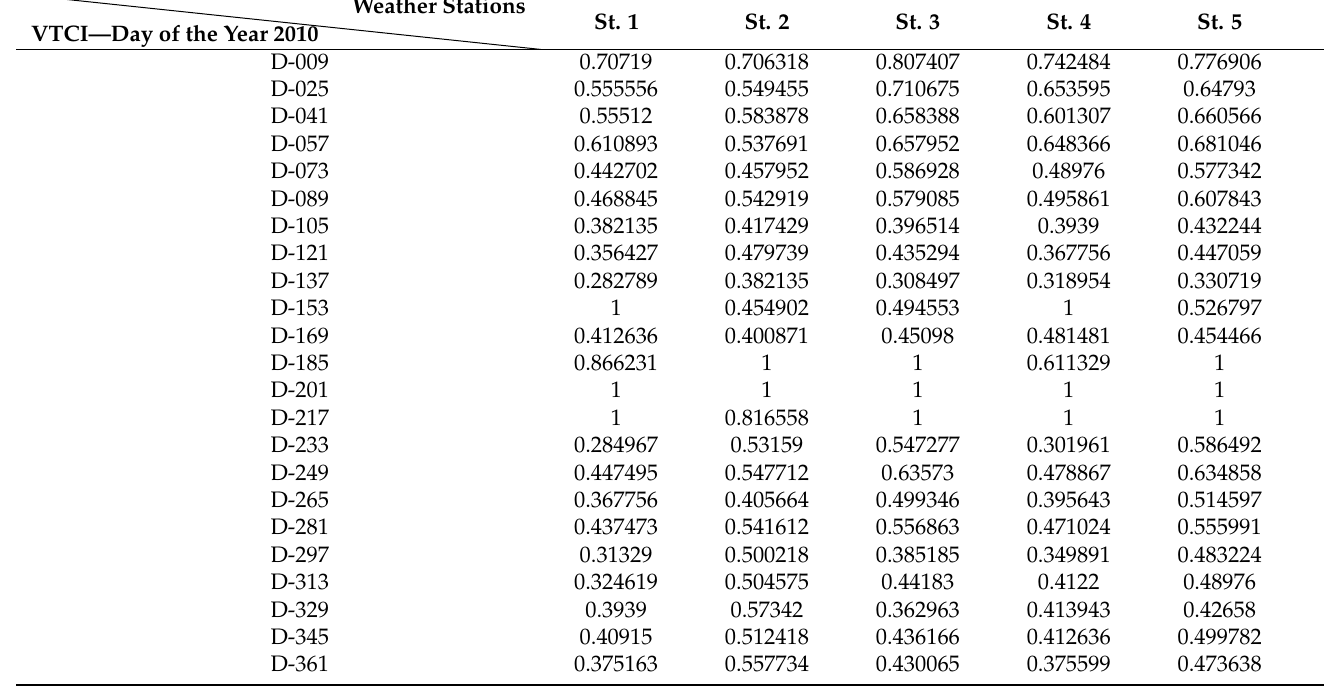
Table 2. VTCI values in each of five meteorological stations (St.) on the day of the year D-009 to D-361 during 2010, per pixel